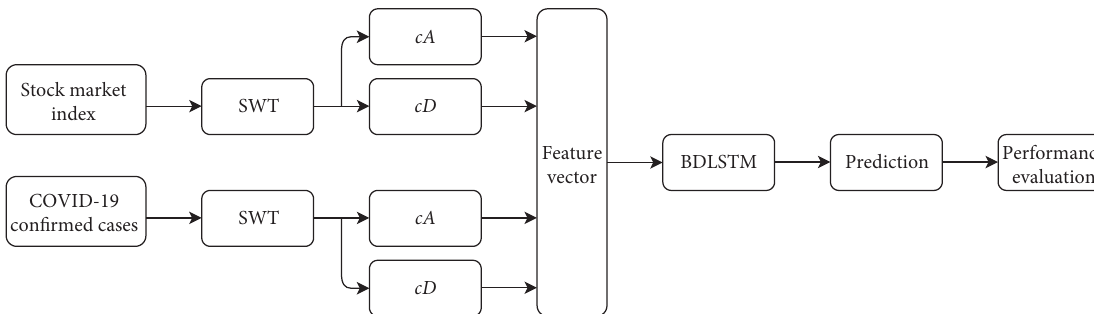
Figure 1: Framework of the proposed system for commodity and stock price prediction during the COVID-19 pandemic (SWT: stationary wavelet transform; cA: approximation coefficients; cD: detail coefficients; BDLSTM: bidirectional long short-term memory